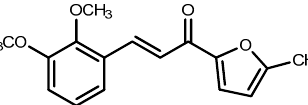
Figure 1. Chemical structure of 3-(2,3-dimethoxyphenyl)-1-(5-methylfuran-2-yl)prop-2-en-1-one (DMFP).